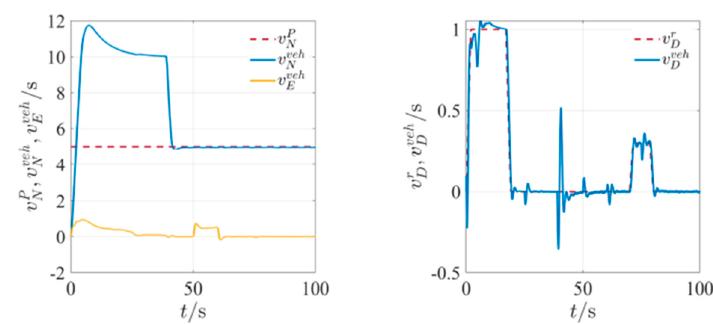
Figure 39. Velocity of the mobile platform during landing process.